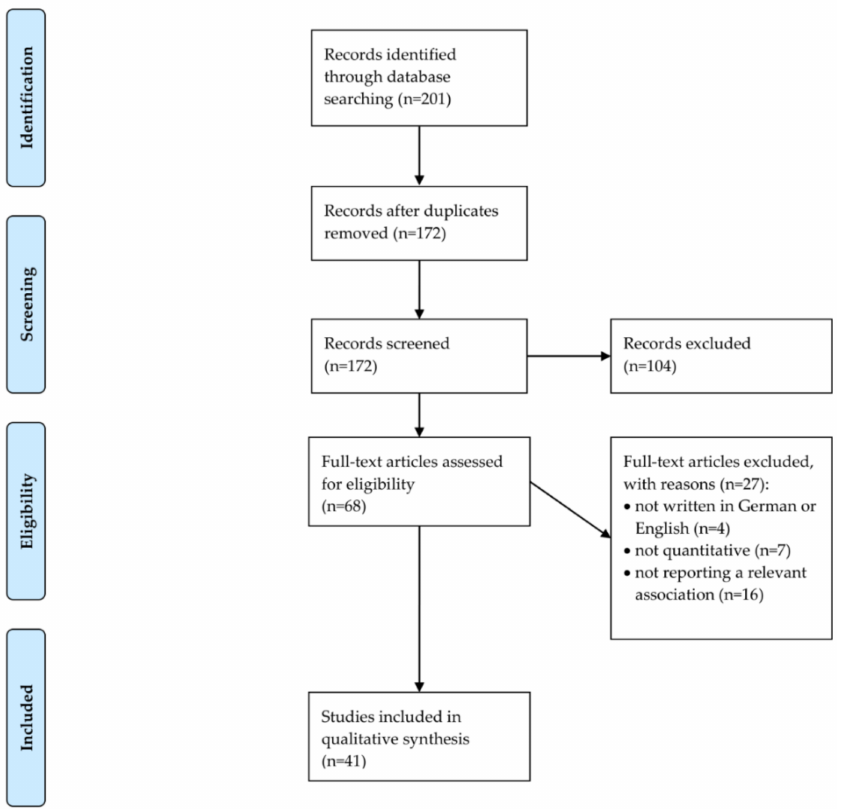
Figure 1. PRISMA 2009 Flow